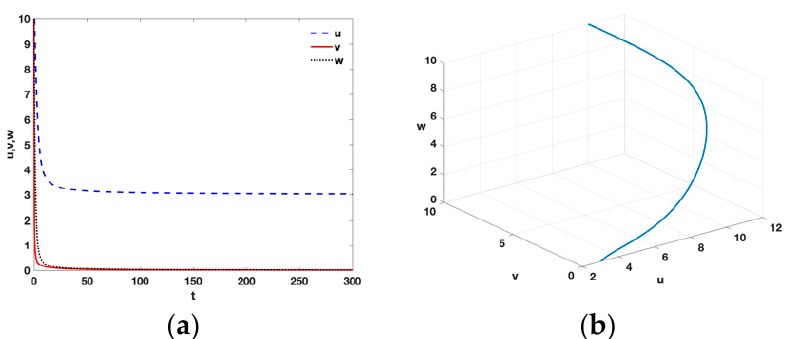
Figure 1. Time series ( a ) and phase diagram ( b ) of equilibrium point A 2 = ( 3,0,0 ) with a = 0.9, m 1 = 1, k 1 = 0.5, b = 1, c = 3, s 1 = 3, d = 2.5, k 2 = 1, m 2 = 1, s 2 = 0, and β = 0.9.